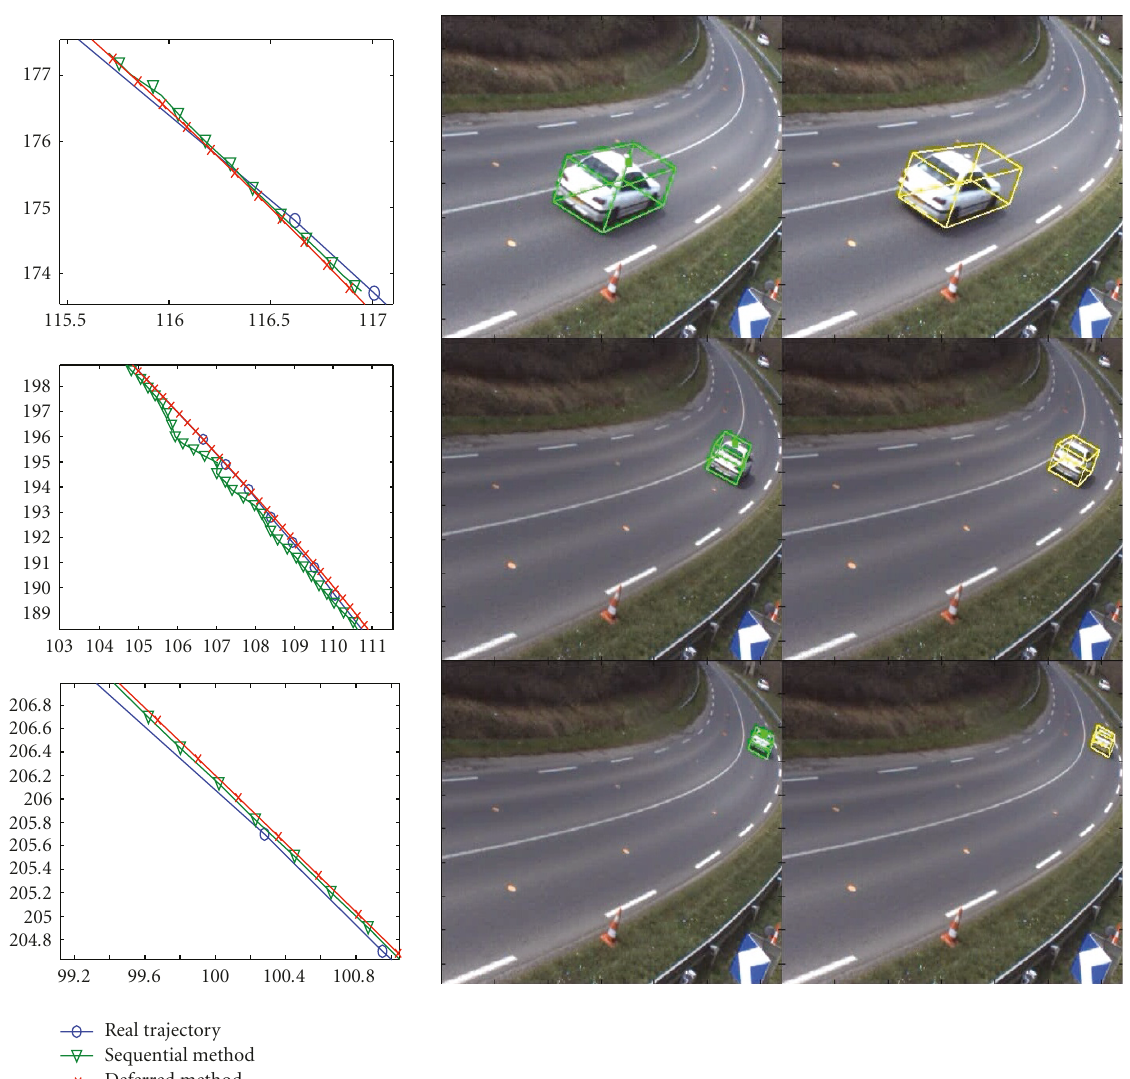
Figure 8: Snapshots illustrating the two methods. Left column: zoom on local trajectories. Middle column: the bounding box illustrates the position of the vehicle estimated with the sequential method. Right column: the bounding box illustrates the position of the vehicle estimated with the sequential